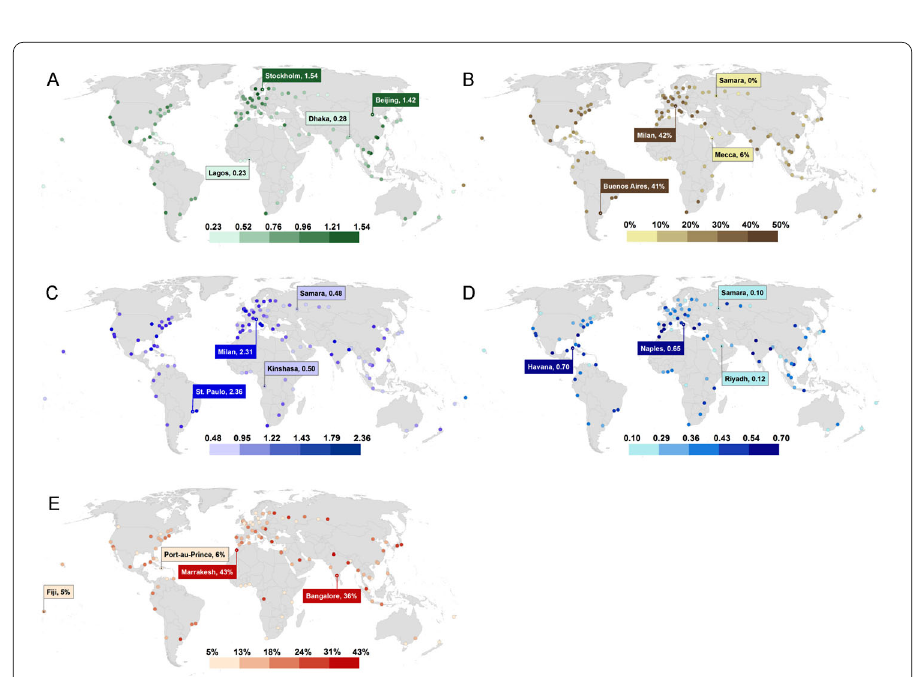
Figure 3 Prevalence of ornamentation elements in global cities. Results of interior elements in 107 global cities indicated regional clustering of prevalence of ( a ) number of plants, ( b ) percentage of homes that include at least one book, ( c ) wall art, ( d ) ornamental decor, ( e ) percentage of homes with vibrant